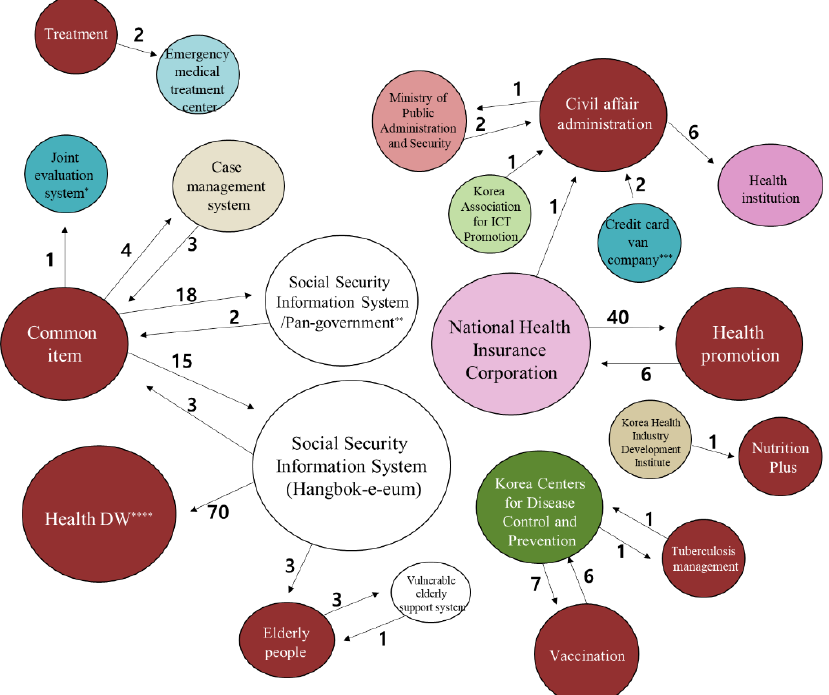
Figure 2. Data linkage status of health promotion projects within the Public Health Information System (PHIS).